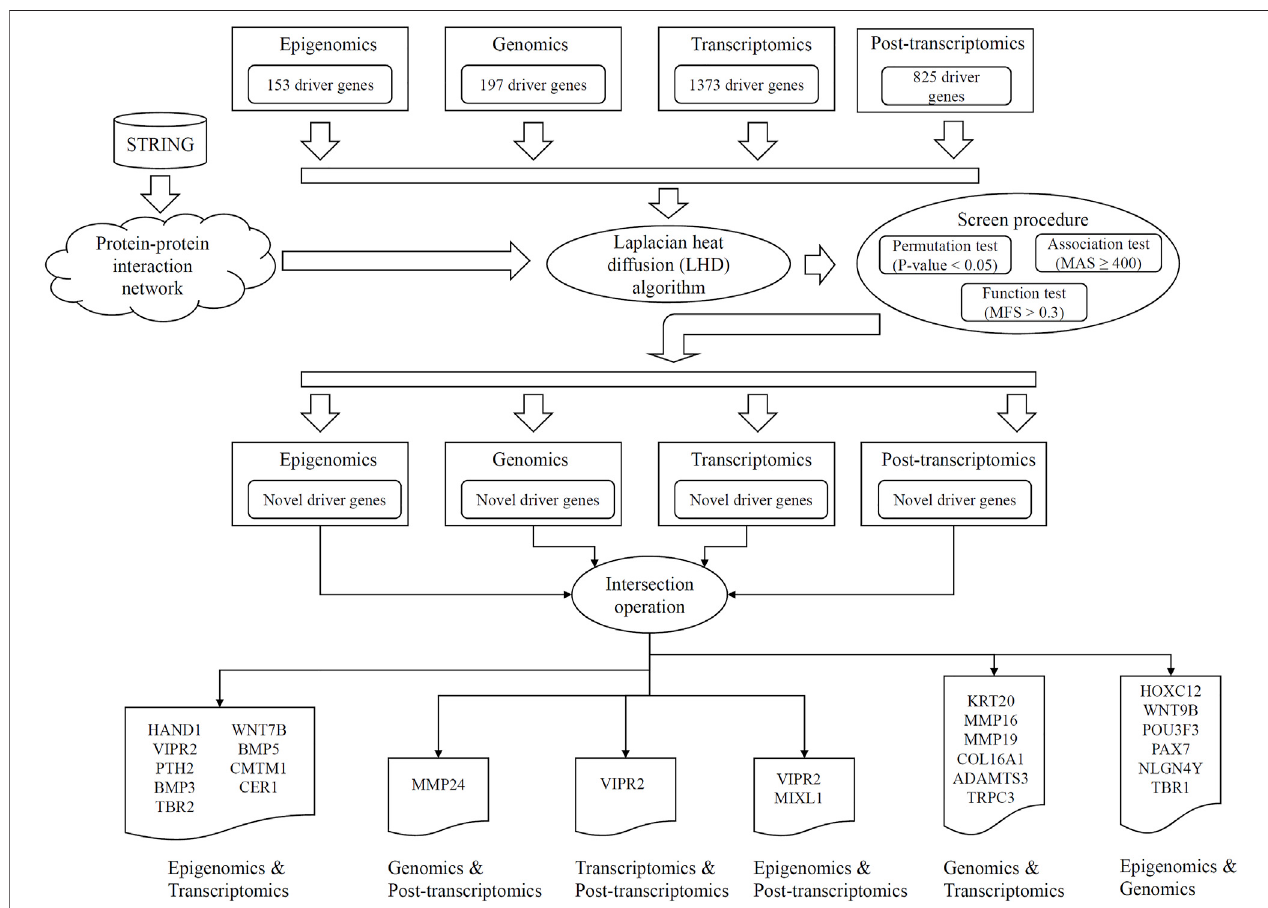
FIGURE 1 | Entire procedures of LHD-based method for identi fi cation of multi-omics lung cancer driver genes. Based on driver genes at one omics level, the Laplacianheatdiffusion(LHD)algorithmisexecutedonaprotein – proteininteractionnetworkreportedinSTRINGtoidentifyrawdrivergenes.Thesegenesare fi lteredby a screen procedure. The intersection operation is conducted to identify driver genes involving any two omics levels. Six groups are accessed, each of which contains driver genes involving two omics levels.